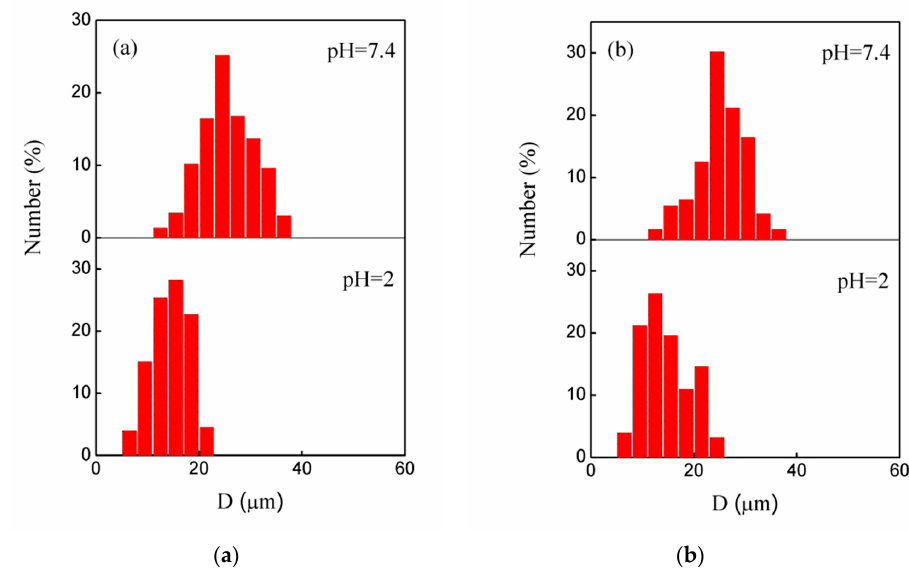
Figure 4. Size distribution of (a) P(AA- co -NVF) and (b) P(AA- co -VAm) microgels at different pH.